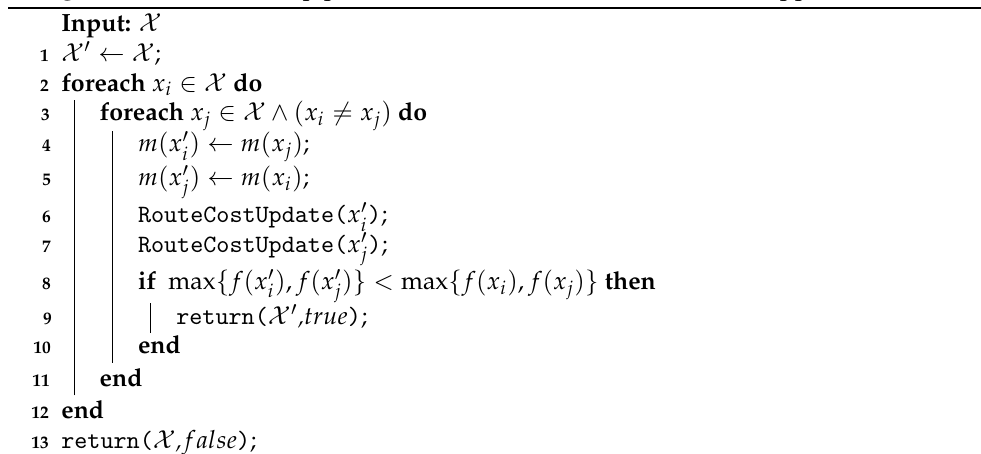
Algorithm 10: UAV Swap performed on EMAS, EMNF, and WEM approaches.